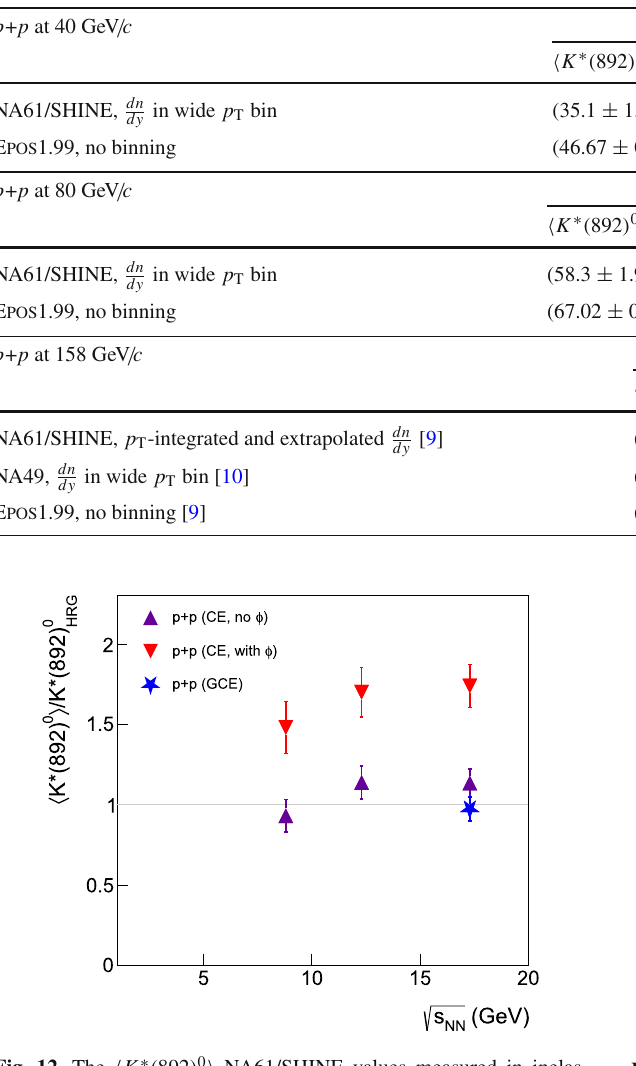
Fig. 12 The (cid:8) K ∗ ( 892 ) 0 (cid:9) NA61/SHINE values measured in inelas- Fig. 13 The (cid:8) K ∗ ( 892 ) 0 (cid:9) / (cid:8) K + (cid:9) and (cid:8) K ∗ ( 892 ) 0 (cid:9) / (cid:8) K − (cid:9) yield ratios tic p+p collisions at p beam = 40–158 GeV / c (this analysis and Ref. obtained in inelastic p+p collisions at p beam = 40–158 GeV / c . The [9]), divided by the hadron resonance gas model predictions within the numerical values are given in Table 10 of Appendix A ( p+p at 40 and Canonical Ensemble [37] for the fit with φ mesons included (upside- 80 GeV / c ) and in Ref. [9] (NA61/SHINE p+p data at 158 GeV / c ) down triangles) and the fit with φ meson excluded (triangles). The star shows the (cid:8) K ∗ ( 892 ) 0 (cid:9) [9] divided by the HRG model prediction for the Grand Canonical Ensemble [37,38]. The numerical values of (cid:8) K ∗ ( 892 ) 0 (cid:9) and K ∗ ( 892 ) 0 are listed in Table 9 of Appendix A HRG